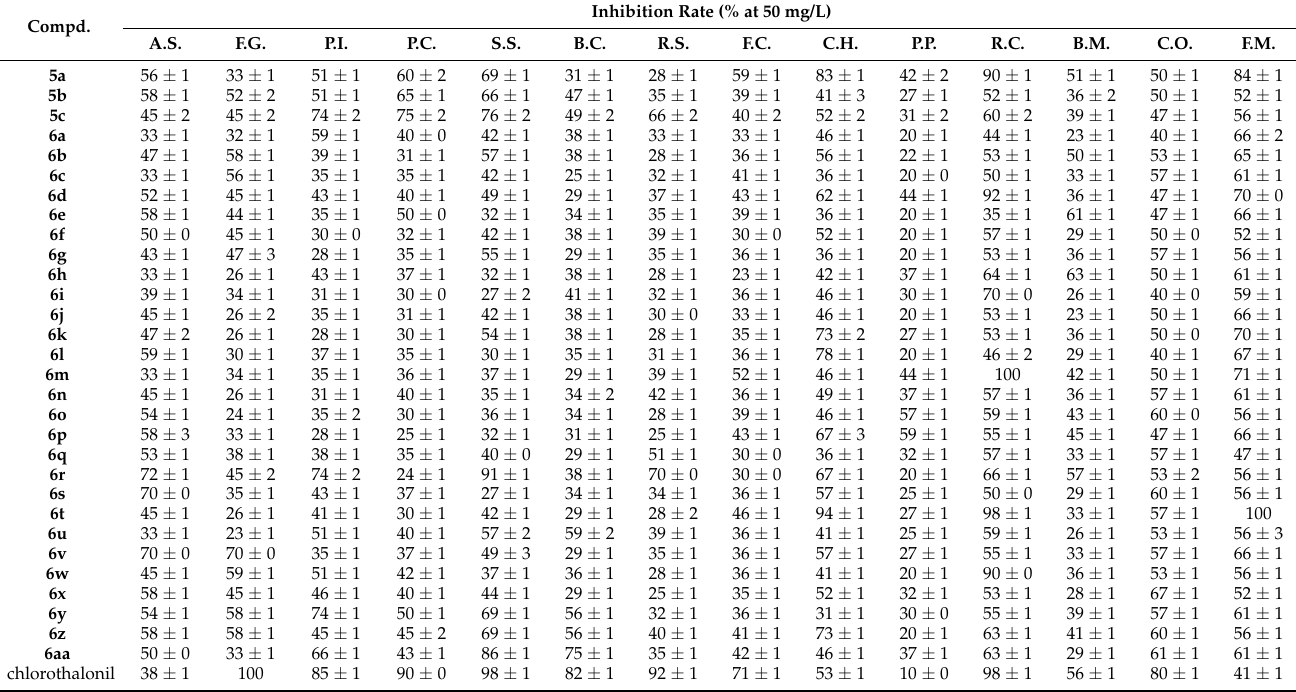
Table 4. Fungicidal activity of compounds 5a − 5c , 6a − 6aa against fourteen kinds of phytopathogens 1 .